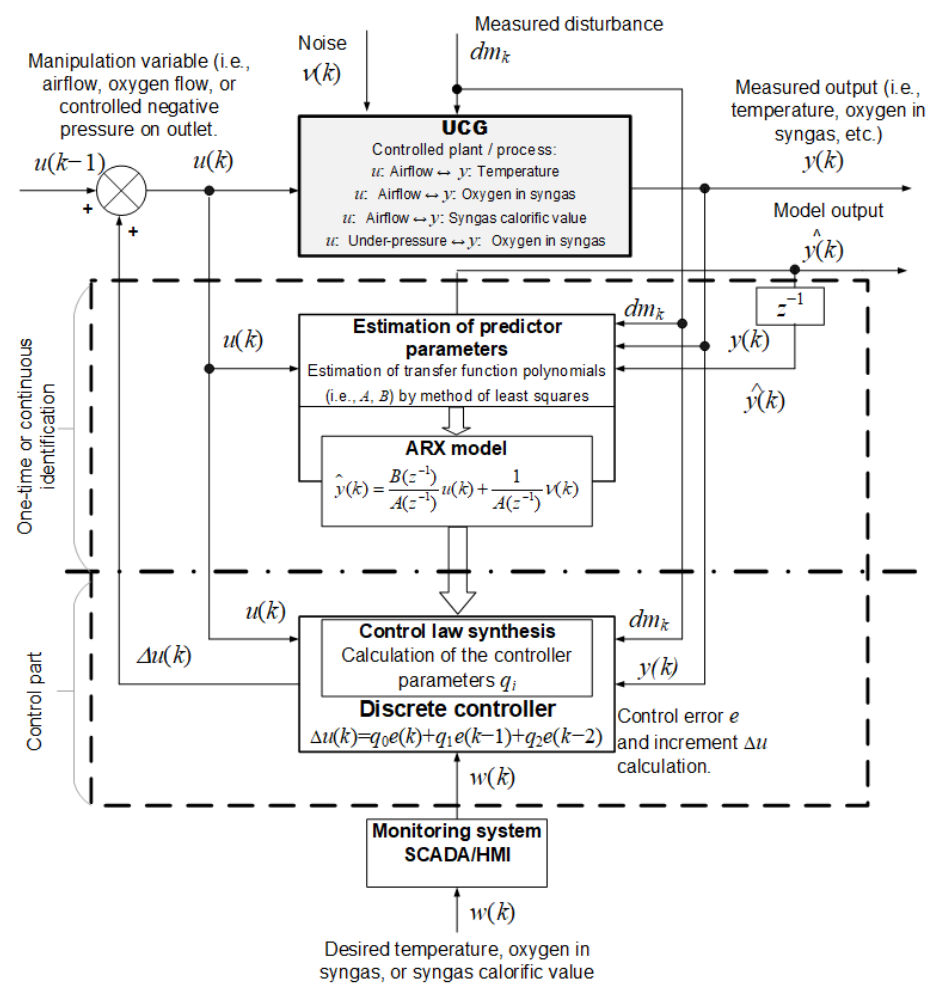
Figure 2. Internal algorithmic structure of adaptive control for stabilization level of UCG.